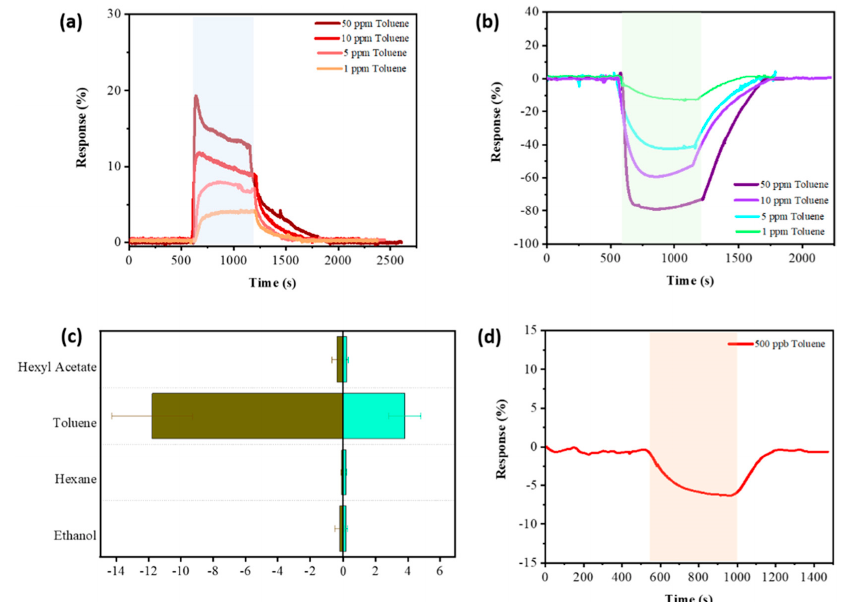
Figure 3. ( a ) Dynamic response curve of the pristine/undoped Ti 3 C 2 T x MXene sensor for toluene response at 1, 5, 10, and 50 ppm at RT, ( b ) dynamic response curve of sulfur-doped Ti 3 C 2 T x MXene sensors for toluene response at 1, 5, 10, and 50 ppm at RT, ( c ) comparison of the real-time response between undoped and doped Ti 3 C 2 T x MXene sensors upon exposure to hexyl acetate, toluene, hexane, and ethanol at a concentration of 1 ppm, ( d ) dynamic response curve of the sulfur-doped Ti 3 C 2 T x MXene sensor at 500 ppb toluene exposure. Reprinted with permission from [91]. Copyright 2020: American Chemical Society.